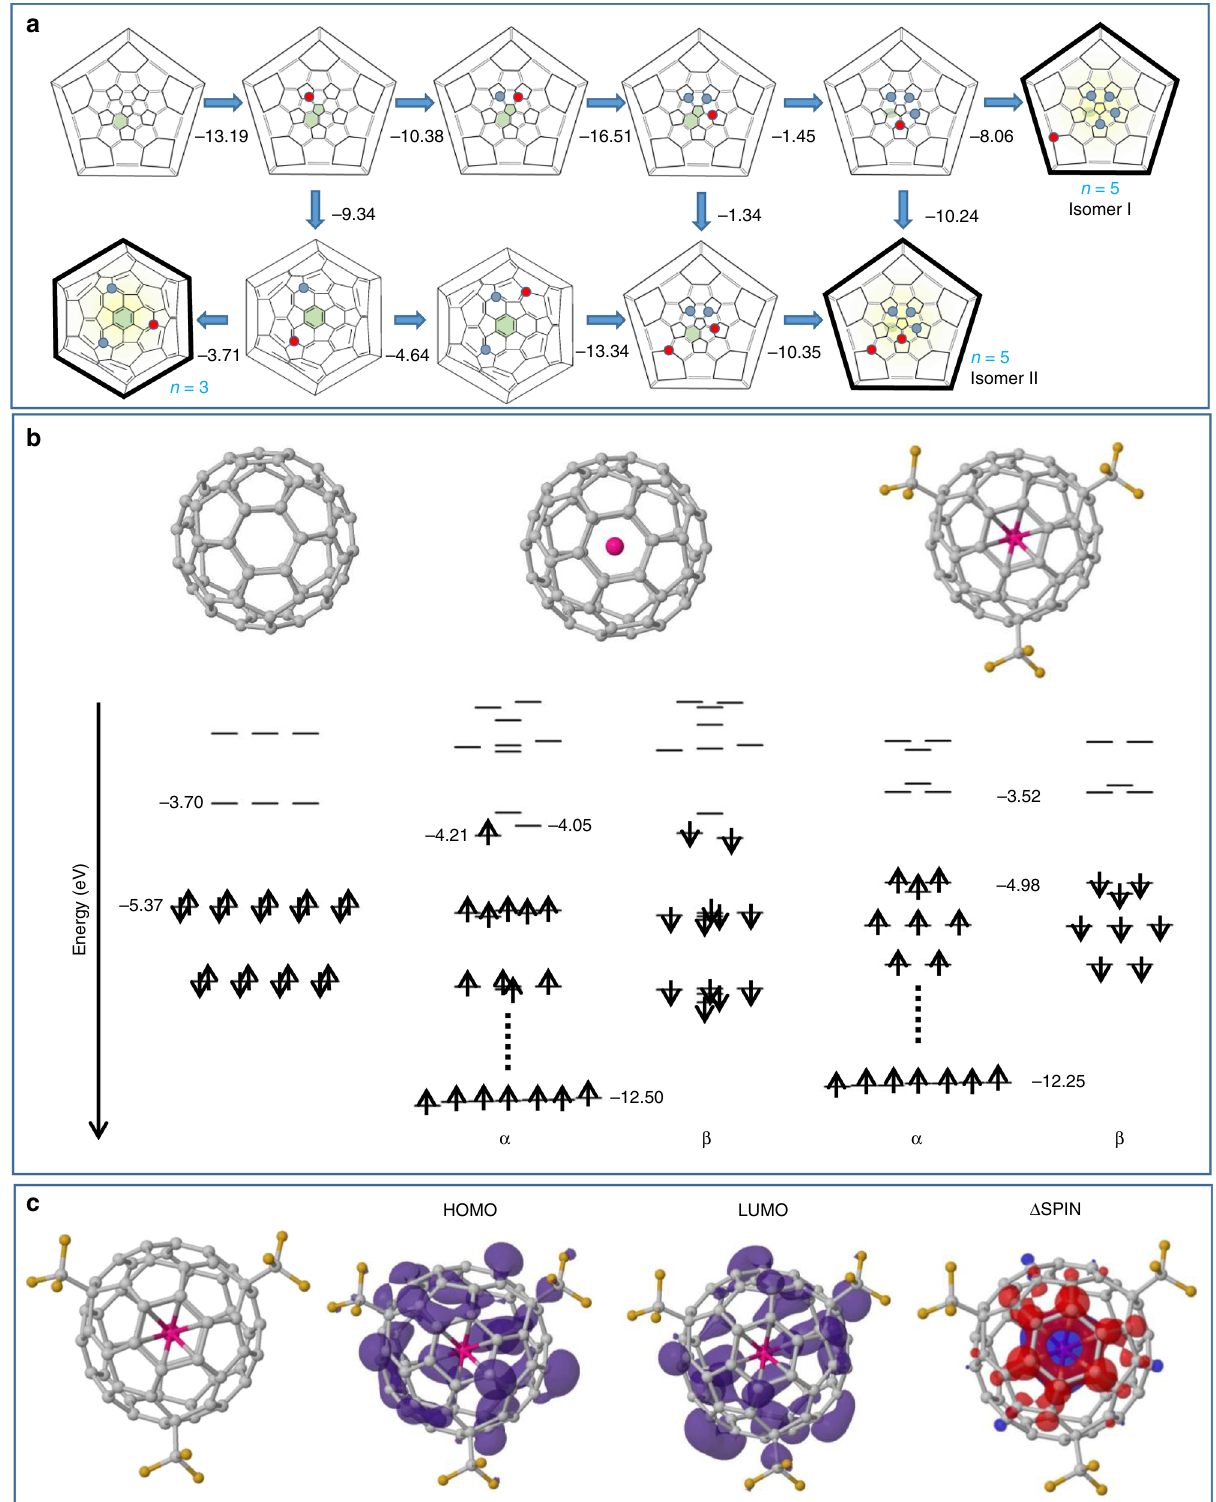
Fig. 2 Calculated functionalization sequences and electronic properties of Gd@C 60 (CF 3 ) n . a Calculated preferential addition sequences for CF 3 to Gd@C 60 . Previous addition sites marked in blue, new addition site in red. Pink shading indicates location of the encapsulated Gd atom. Numbers indicate energy release in kcal mol − 1 according to the reaction Gd@C 60 (CF 3 ) n − 1 + ½ (CF 3 ) 2 → Gd@C 60 (CF 3 ) n . All pathways are shown where isomers are within 2.3 kcal mol − 1 of the most stable. Fullerenes where next addition is endothermic have black outlines and represent stable end points of a reaction pathway. b Calculated Kohn-Sham eigenvalues (eV) for (left) C 60 , (center) Gd@C 60 , and (right) Gd@C 60 (CF 3 ) 3 , showing CF 3 functionalization results in a closed- shell system, reopening the HOMO-LUMO gap to nearly that of C 60 . c Spatial distribution of calculated Kohn-Sham eigenstates showing highest occupied molecular orbital (HOMO) and lowest unoccupied molecular orbital (LUMO) and their neighboring states around the Fermi level for the most stable Gd@C 60 (CF 3 ) 5 (I) isomer. The states are delocalized across the fullerene cage with very limited CF 3